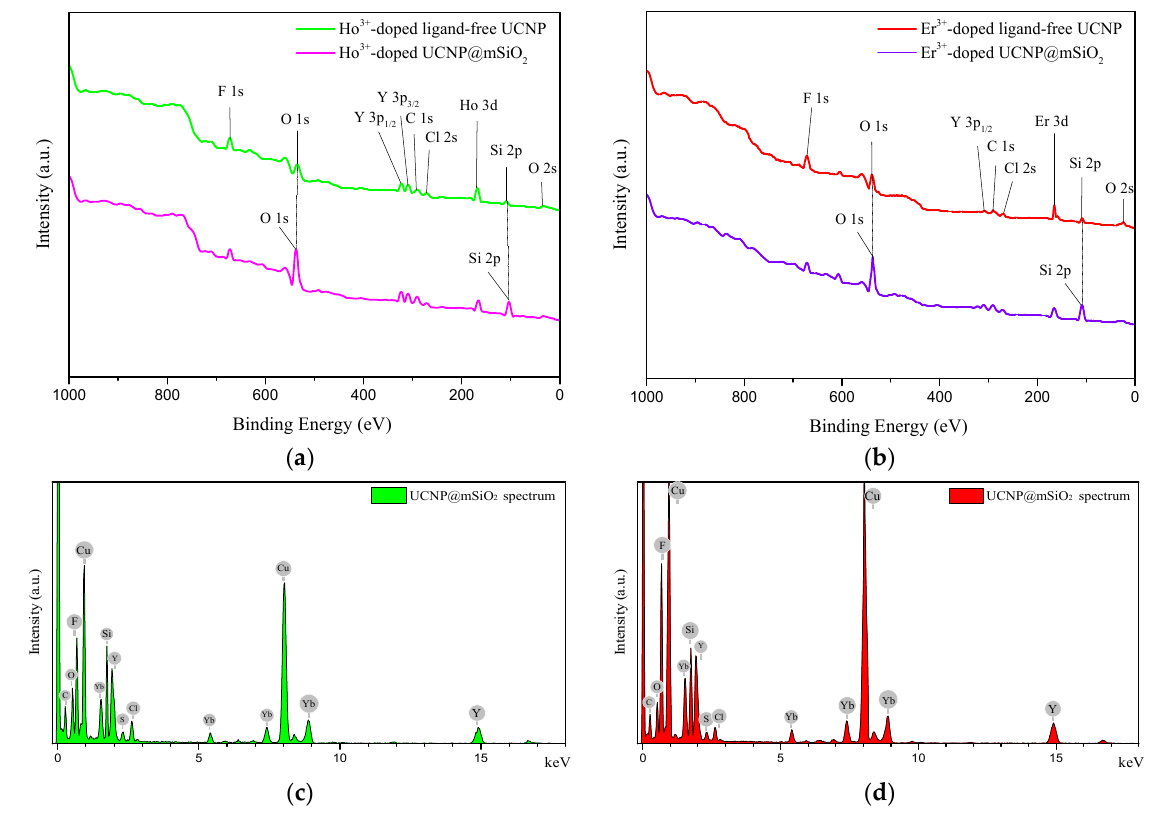
Figure 4. XPS spectra of ( a ) ligand-free and mSiO 2 -coated LiYF 4 :Yb 3+ 0.25 ,Ho 3+ 0.01 @LiYF 4 :Yb 3+ 0.2 nanoparticles and ( b ) ligand-free and mSiO 2 -coated LiYF 4 :Yb 3+ 0.25 ,Er 3+ 0.01 @LiYF 4 :Yb 3+ 0.2 nanoparticles. EDS spectra of ( c ) mSiO 2 -coated LiYF 4 :Yb 3+ 0.25 ,Ho 3+ 0.01 @LiYF 4 :Yb 3+ 0.2 nanoparticles and ( d ) mSiO 2 -coated LiYF 4 :Yb 3+ 0.25 ,Er 3+ 0.01 @LiYF 4 :Yb 3+ 0.2 nanoparticles.